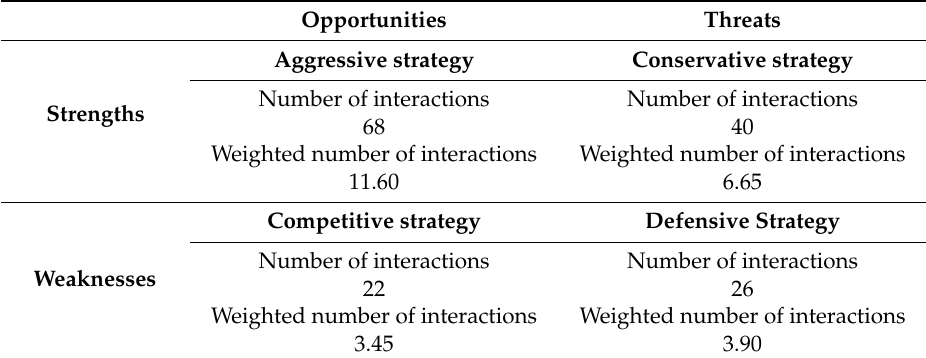
Table 10. Results of the strategic analysis and strategy selection. Source: own